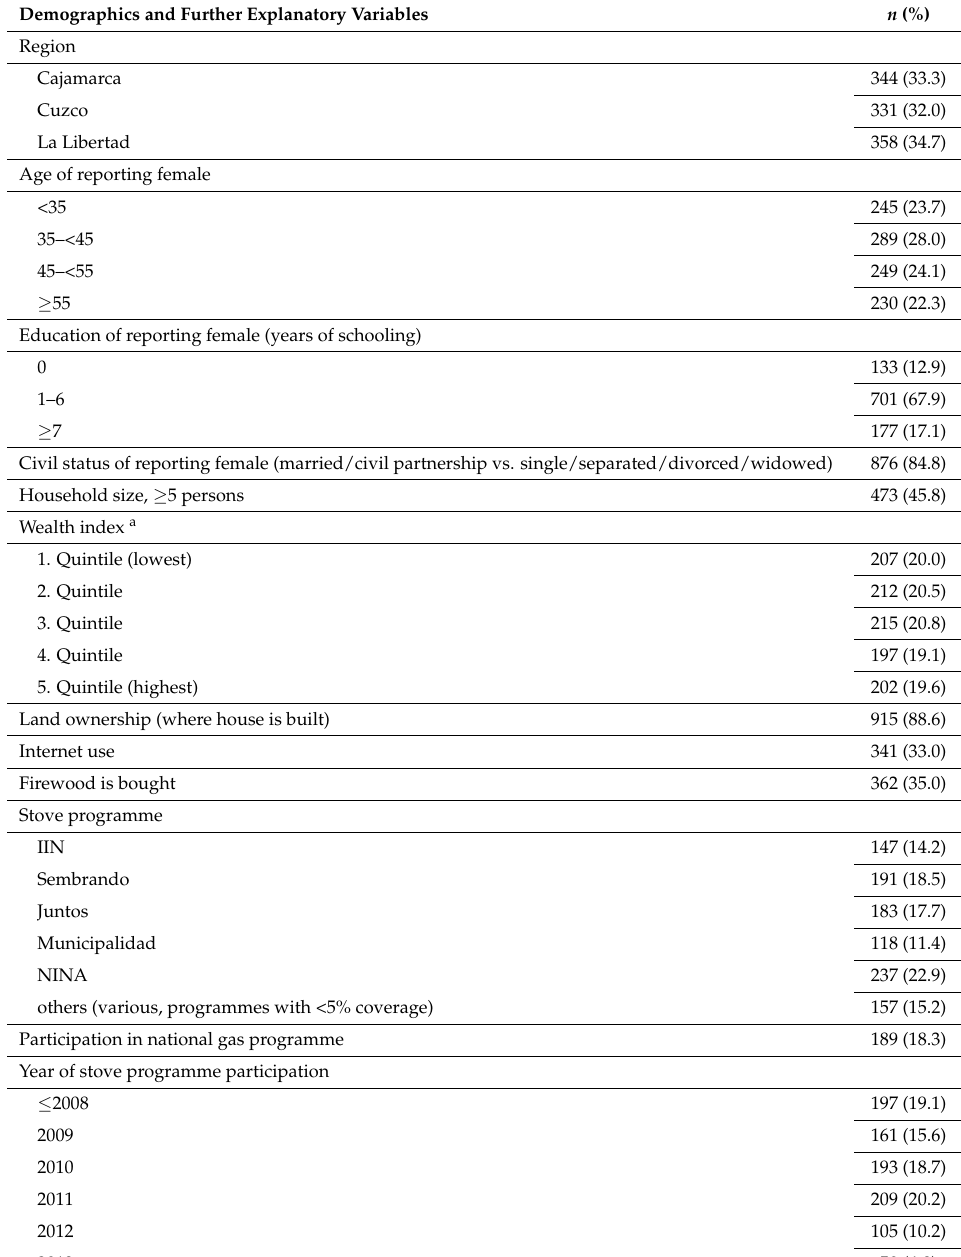
Table 1. Background and stove adoption information for 1033 households in three regions of